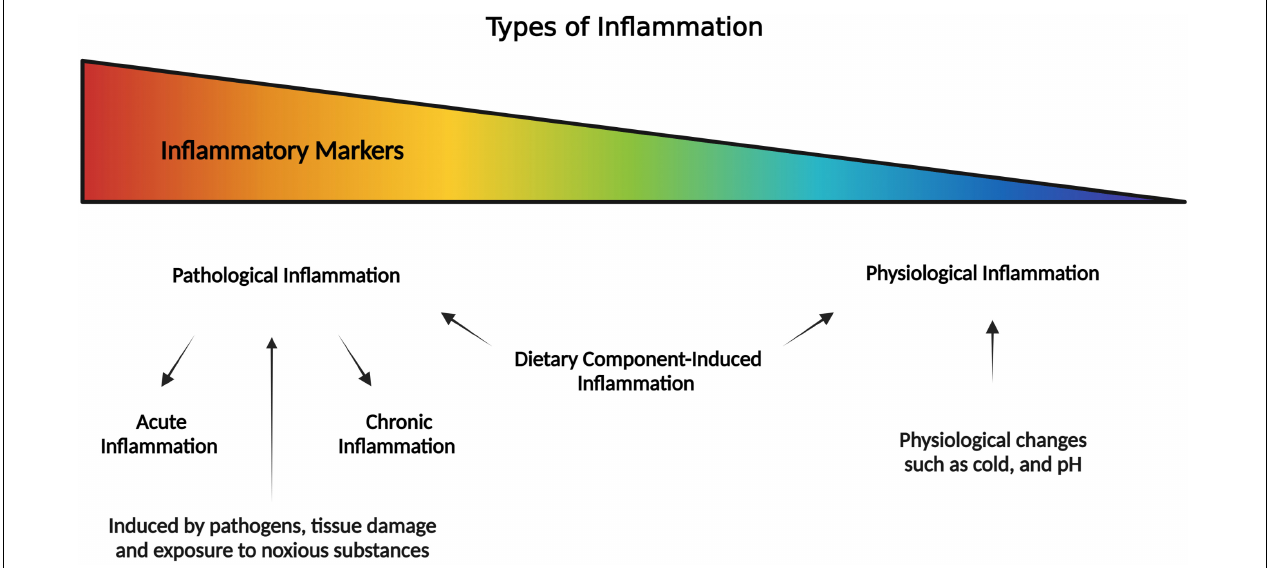
FIGURE 1 | Pictorial representation of the spectrum of inflammation where it is pathological inflammation at one extreme, and physiological inflammation at the other extreme (as part of normal homeostasis). In the middle of the spectrum is the dietary component-induced inflammation which is a special case that may lead to pathological or physiological